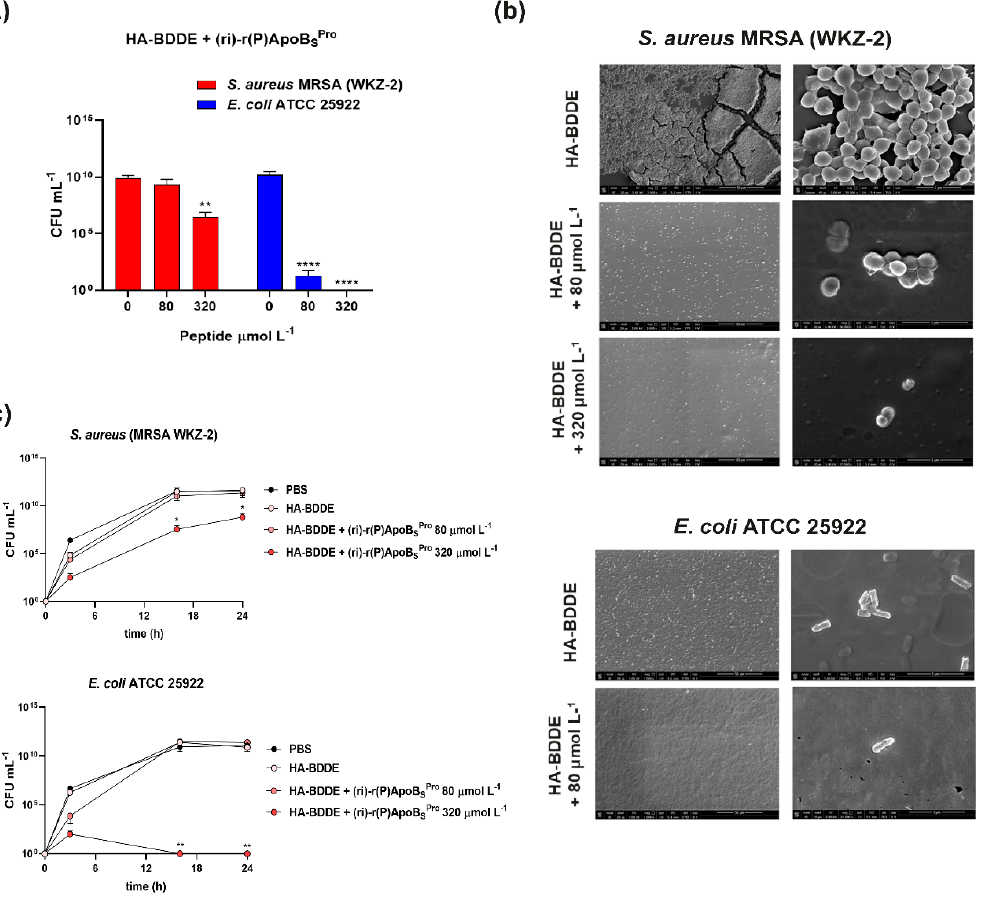
Figure 6. Antimicrobial activity of HA-BDDE hydrogel functionalized with the peptide. ( a ) Antimi- crobial efficacy of HA-BDDE hydrogel system loaded with (ri)-r(P)ApoB SPro against methicillin-re- sistant S. aureus (MRSA WKZ-2) and E. coli ATCC 25922 bacterial strains; reported data refer to assays performed in triplicate. ( b ) Morphological analyses by SEM of methicillin-resistant S. aureus (MRSA WKZ-2) and E. coli ATCC 25922 bacterial strains treated with HA-BDDE functionalized or not with r(P)ApoB SPro . ( c ) Bacterial migration across surfaces coated with PBS, unfunctionalized HA- BDDE hydrogel system, or HA-BDDE hydrogel system functionalized with (ri)-r(P)ApoB SPro . Sig- nificant differences were indicated as * p < 0.05, ** p < 0.0) and **** p < 0.0001 for treated vs. control samples. 3.8. Biocompatibility of HA-BDDE Hydrogel System Loaded with (ri)-r(P)ApoB SPro on Human Skin Cell Cultures To evaluate the biocompatibility of HA-BDDE hydrogel system loaded with (ri)- r(P)ApoB SPro peptidomimetic toward human skin cell cultures, MTT assays were per- formed on immortalized human keratinocytes (HaCaTs) and on normal human fibro- blasts (HDFs). Results indicated that HA-BDDE hydrogels loaded with 80 or 320 µmol L − 1 (ri)-r(P)ApoB SPro did not affect the viability of HaCaT and HDF cell lines (Figure 7). A significant improvement of cell viability was, instead, detected when the cells were incu- bated with an unfunctionalized HA-BDDE hydrogel system or with HA-BDDE hydrogel loaded with 320 µmol L − 1 peptidomimetic (Figure 7). This can be explained by considering that, as a major component of the extracellular matrix, hyaluronic acid plays a key role in skin repair mechanisms being able to enhance the proliferation and differentiation of en- dothelial cells and to facilitate cell migration during the wound healing process [46,47]. The overall results highlight the biocompatibility of the HA-BDDE hydrogel system